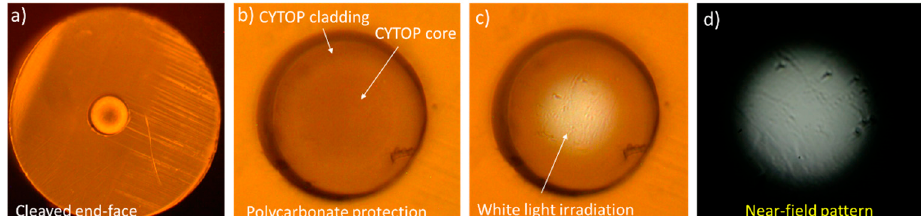
image ( b ). ( a ) cleaved end-face, ( b ) CYTOP core-cladding region, ( c ) CYTOP core-cladding region when white light was launched into the fiber, ( d ) near-field intensity pattern.